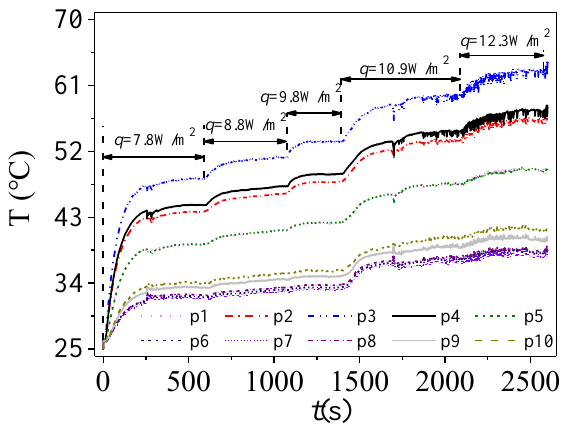
Figure 4. Temperature dynamic variation of the evaporator and condenser walls ( H = 20 mm, ϕ = 52%, q = 7.8 W/cm 2 ).